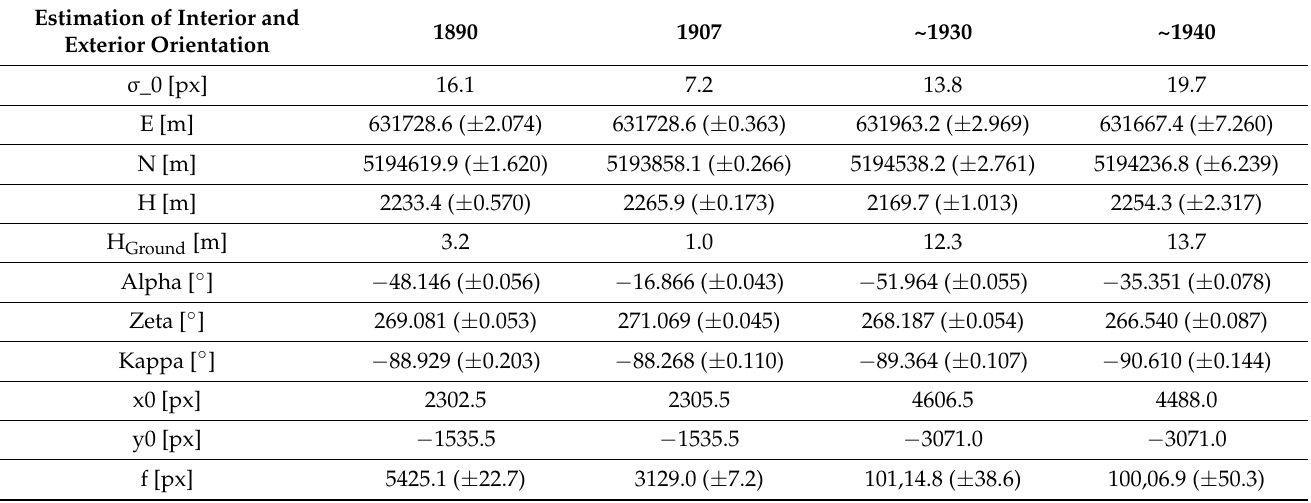
Table 2. Calculated coordinates of the projection centre (east [E], north [N], height [H]) and the corresponding height above ground [H Ground ], rotation angle of the camera (Alpha, Zeta, Kappa), coordinates of the principal point (x0, y0) and focal length f. σ _0 represents the mean reprojection error. The corresponding standard deviations are given in brackets. The coordinates refer to the ETRS89/UTM Zone 32N coordinate system (EPSG code: